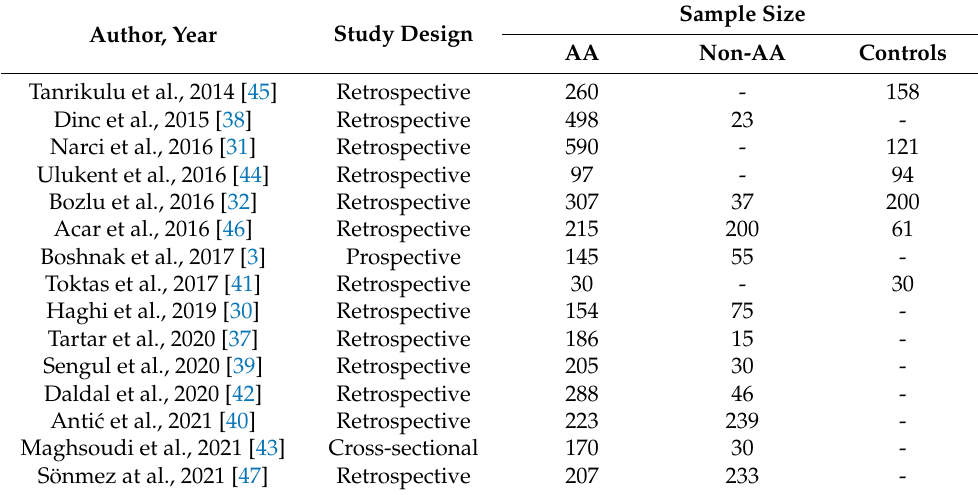
Figure 1. Selection of the relevant studies using the PRISMA flow diagram. Table 1. Baseline characteristics of the included